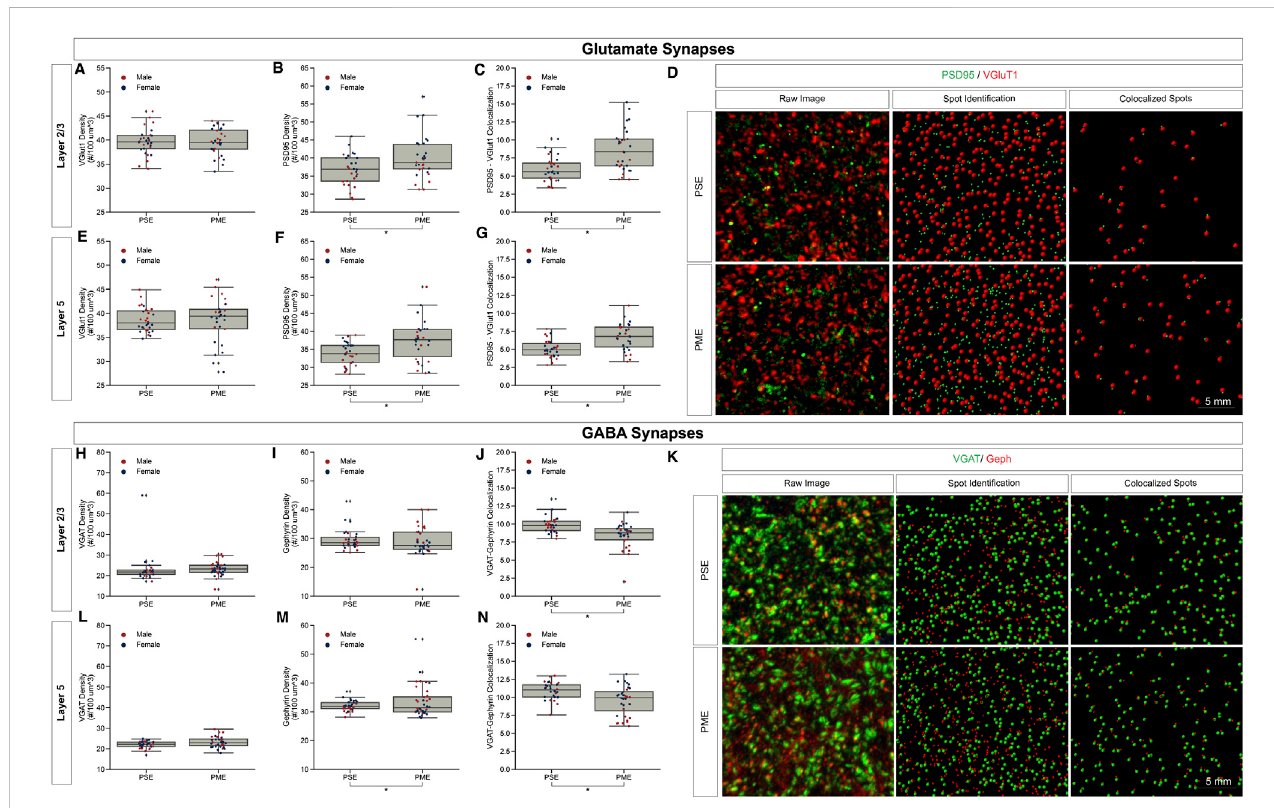
FIGURE 5 Neurochemical assessment of functional Glutamatergic and GABAergic synapses. In Layer 2/3 (A) vesicular glutamate transporter (VGlut1) density was unaltered, but PME increases (B) post-synaptic density (PSD95) density ( t -test, p = 0.0141) and (C) increases PSD95-VGlut1 colocalization ( t -test, p = 0.0001). An exemplary (D) confocal stack of PSD95 (green) and VGlut1 (red) double-stained image between PME and PSE, noting the raw image, the output of spot detection usingImaristoidentifypuncta,andcolocalizedspotsde fi nedbyspotswithin0.5 µmofeachother.InLayer5 (E) VGlut1 densitywasunaltered, butPMEincreases (F) PSD95density( t -test, p =0.0031)and (G) increasesPSD95-VGlut1colocalization( t -test, p =0.0001).n=8(3M:5 F)PME,8PSE(4M:4 F). In Layer 2/3 both (H) vesicular GABA transporter (VGAT) density and (I) post-synaptic density (gephyrin) density was unaltered, but PME (J) decreases Gephyrin-VGAT colocalization ( t -test, p = 0.0005). An exemplary (K) confocal stack of gephyrin (green) and VGAT (red) double-stained image between PME andPSE,notingtherawimage,theoutputofspotdetectionusingImaristoidentifypuncta,andcolocalizedspotsde fi nedbyspotswithin0.5 µm.InLayer5